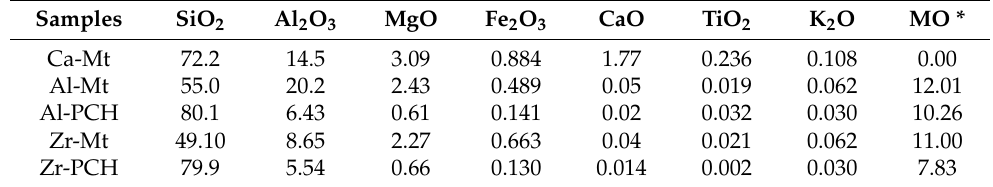
Table 1. Chemical analysis of some oxides (in mass %) of Ca-Mt, Al-Mt, Zr-Mt, and their PCH derivatives.